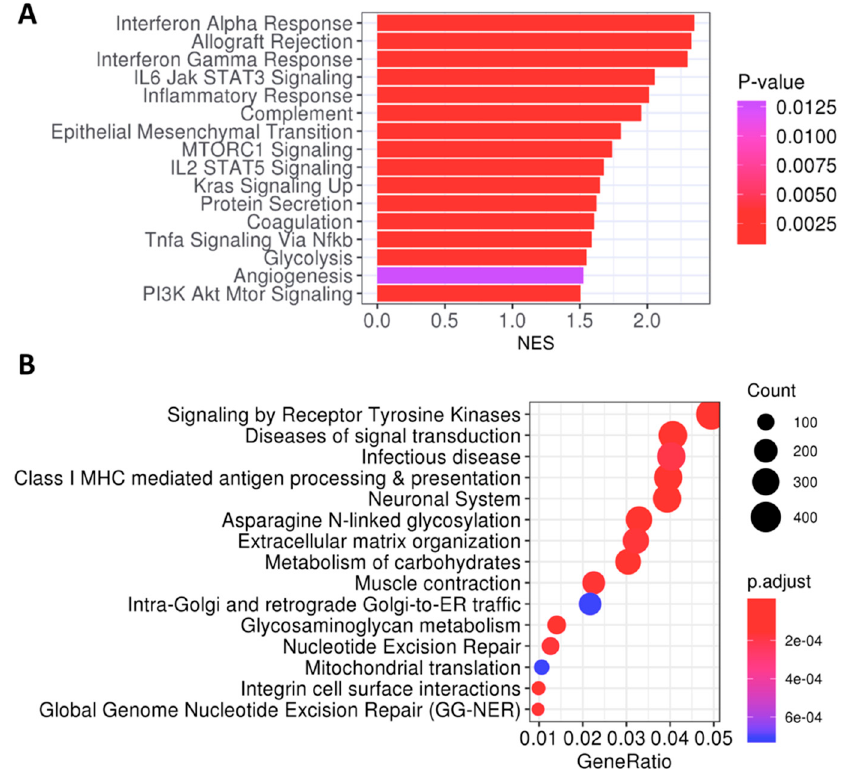
Figure 5. Functional analysis of recurrent tumors within phenotypes “High Angio-High AP” ( n = 45) versus “Low Angio-Low AP” ( n = 16). ( A ) Bar plot of enriched Hallmarks from pre-ranked GSEA analysis, ordered by NES and colored by p -values. ( B ) Dot plot of enriched pathways from DEGs in “High Angio-High AP” phenotype, colored by adjusted p -values. GeneRatio correspond to the frequency of genes from the gene set in the list of DEGs. Count represents the total number of genes. GSEA: Gene Set Enrichment Analysis, NES: Normalized Enrichment Score, DEGs: Differentially Expressed Genes.